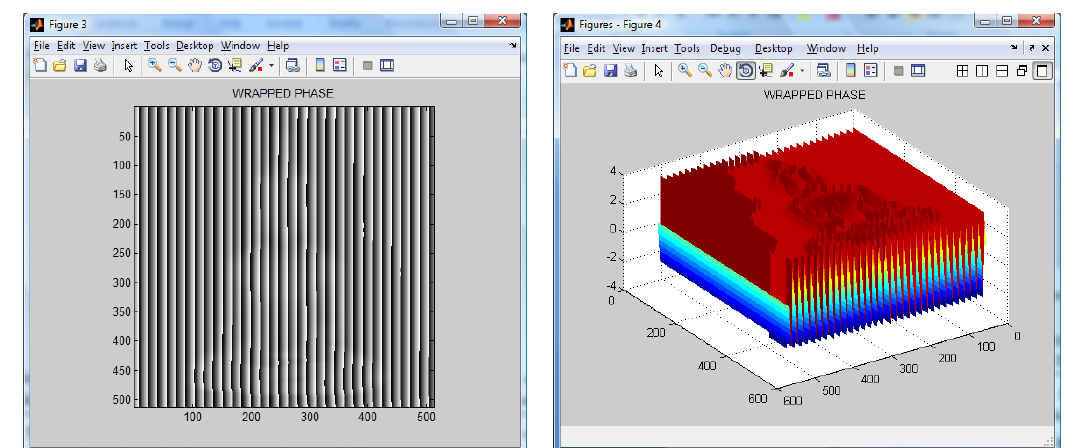
Figure 5. Wrapped phase (image and